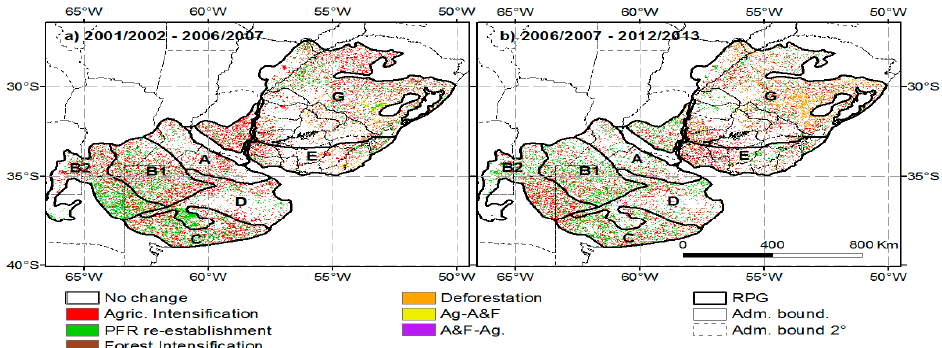
Figure 6. LULC change maps in RPG occurred in two time periods: (a) between 2001 / 2002 and 2006 / 2007; ( b ) between 2006 / 2007 and 2012 / 2013. Agric. Intensification: Agricultural Intensification. PFR re-establishment: passage of agricultural categories to Perennial Forage Resources (PFR). Forest Intensification: passage from PFR to A ff orestation and Forest (A&F). Deforestation: passage from